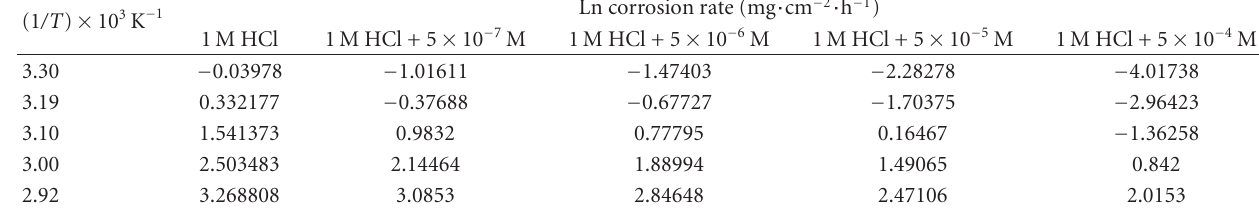
Table 3: The data obtained from the weight loss measurements for Arrhenius equation: ( I/T ) against ln (corrosion rate). (1 /T ) × 10 3 K − 1